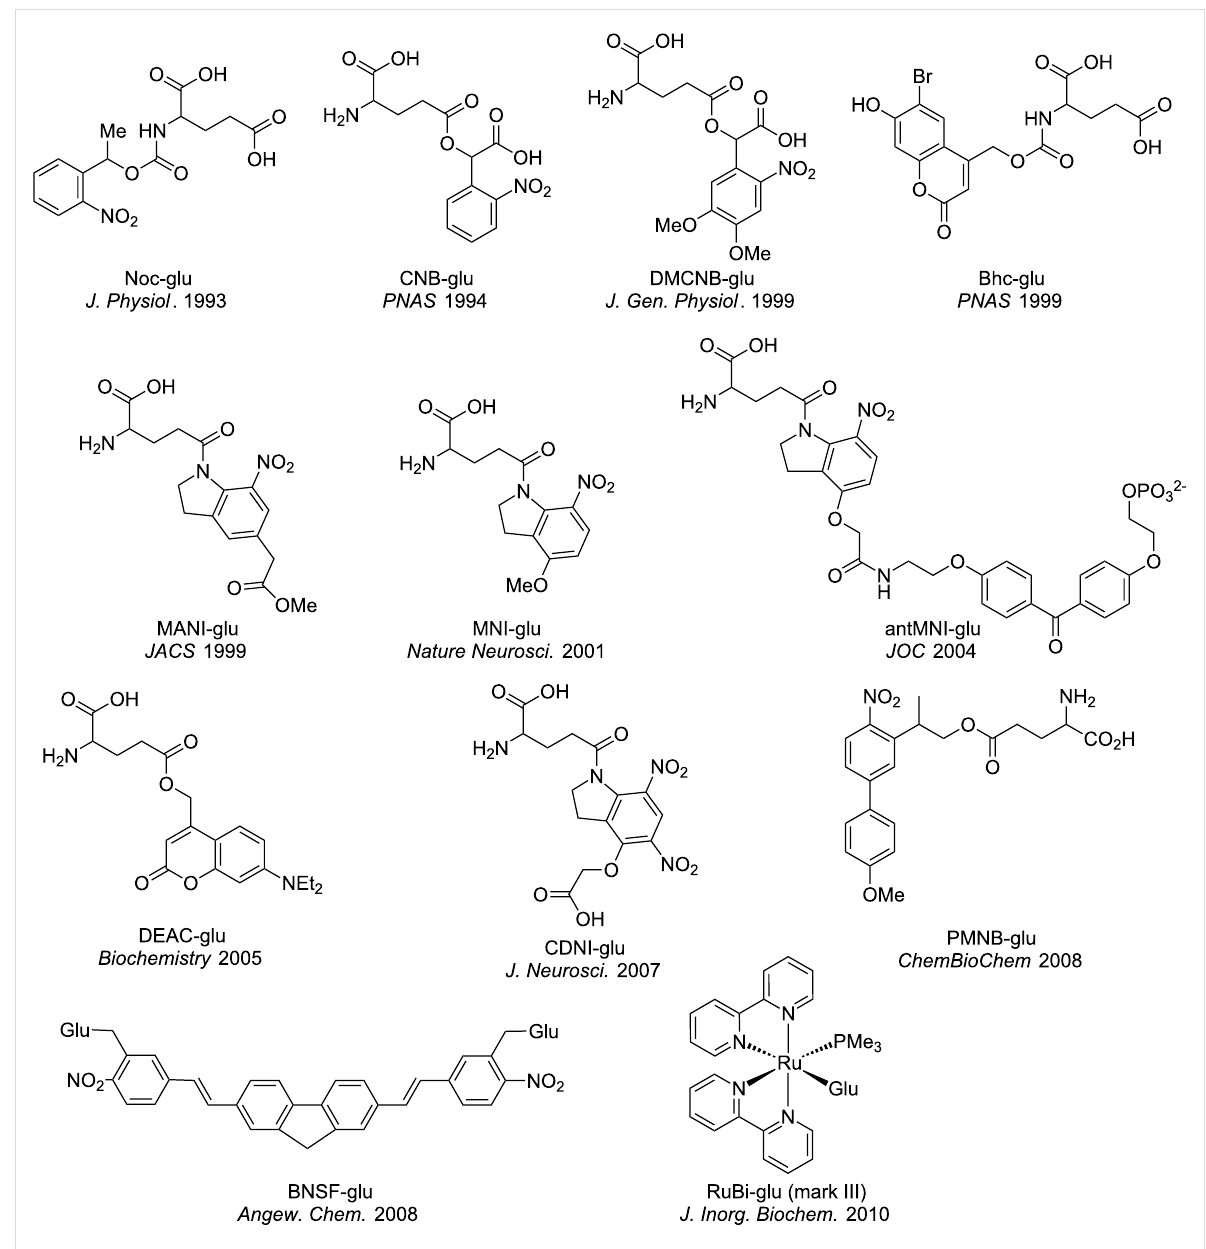
Figure 1: Structures of various caging chromophores. Abbreviations: Noc, N -nitrophenethyloxycarbonyl; CNB, carboxynitrobenzyl; DMCNB, dimethoxycarboxynitrobenzyl; Bhc, bromohydroxycoumarin; MANI, methylacetoxynitroindolinyl; MNI, methoxynitroindolinyl; antMNI, antennea- methoxynitroindolinyl; DEAC, diethylaminocoumarin; CDNI, carboxymethylnitroindolinyl; PMNB, propylmethoxynitrobiphenyl; BNSF, bisnitropropyl- styrylfluorene; RuBi, ruthenium-bipyridine.